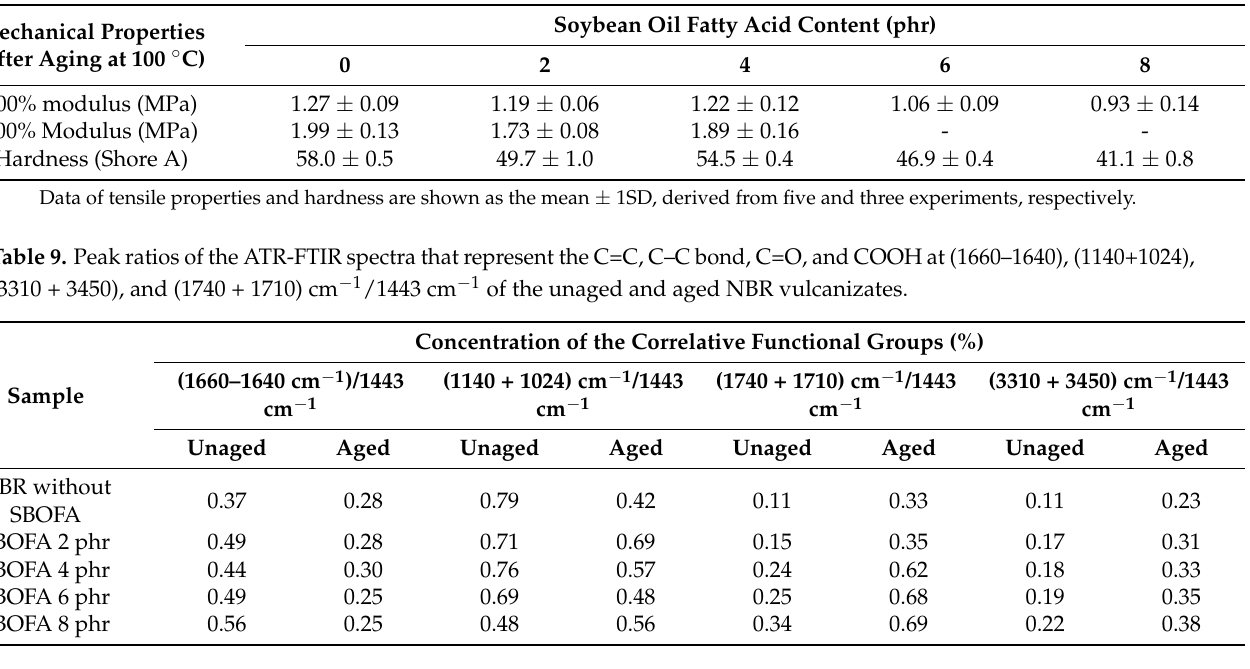
Table 8. Mechanical properties of the aged NBR vulcanizates with varying SBOFA loadings. Mechanical Properties